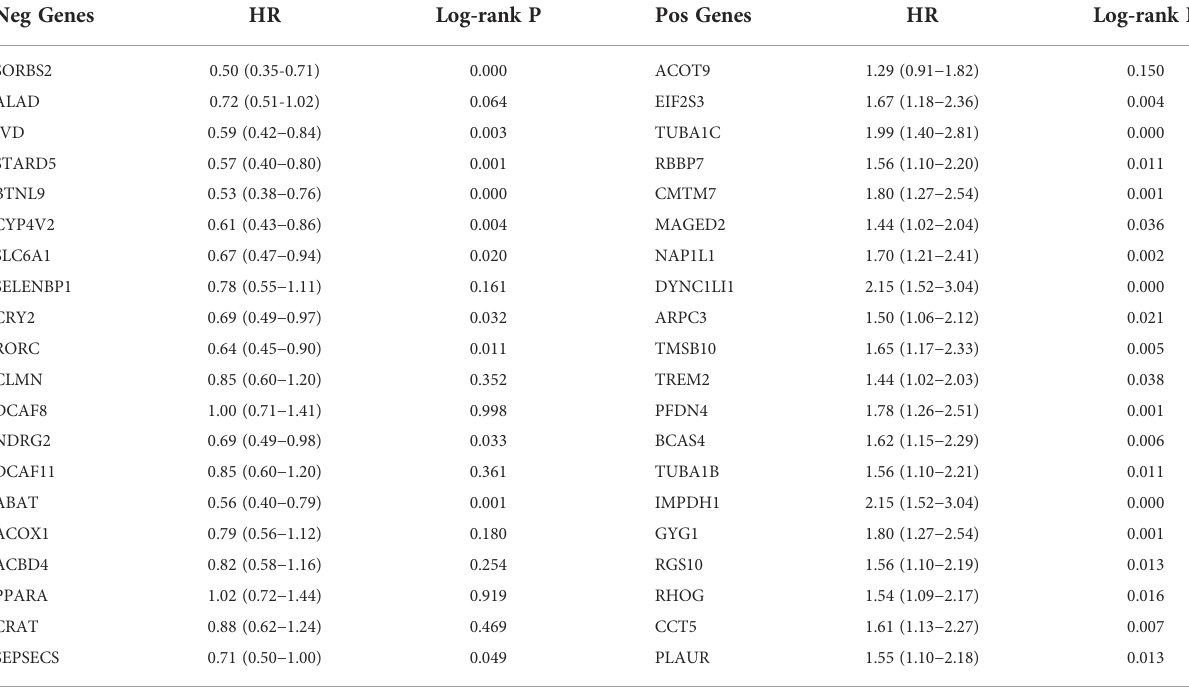
TABLE 3 Overall survival analysis of the top 20 genes positively and negatively correlated with SMS in